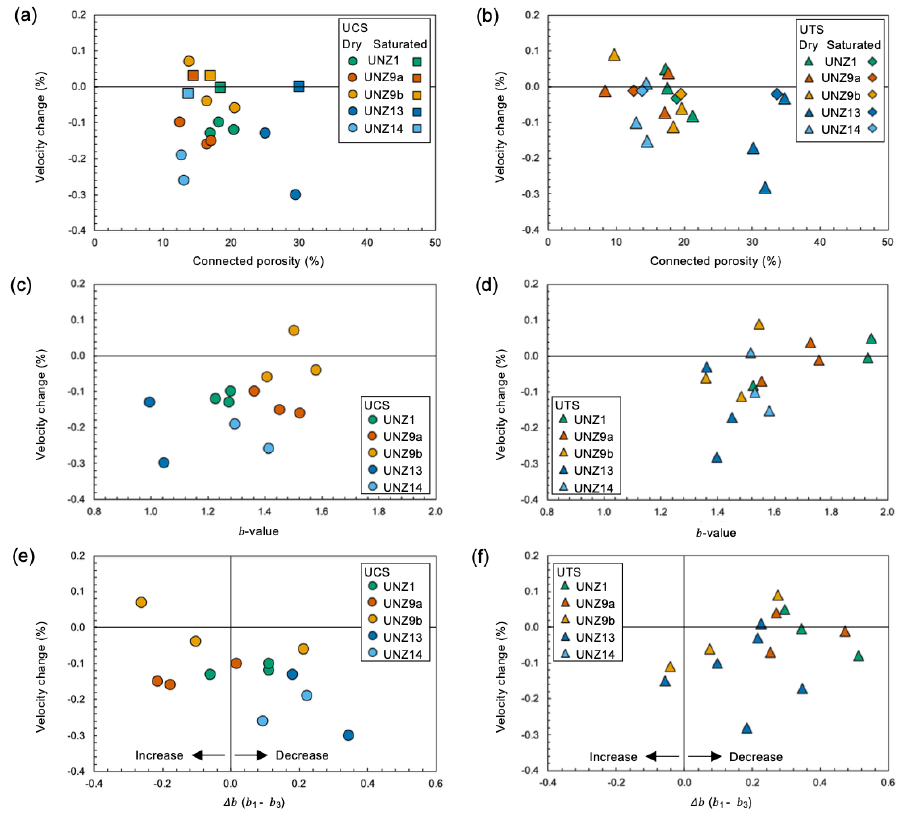
Figure 9. Magnitude of velocity change during mechanical testing compared to connected porosity for dry and saturated (a) UCS and (b) UTS tests, showing no correlation for dry UCS tests, a minor negative correlation for dry UTS tests, and no change for saturated tests. Magnitude of velocity change compared to the b value calculated from acoustic emission monitoring, showing a weak positive correlation for dry (c) UCS and (d) UTS tests. Magnitude of velocity change compared to the (cid:49)b value ( b 1 − b 3 ) during dry (e) UCS and (f) UTS tests, showing a disparate correlation in compression and